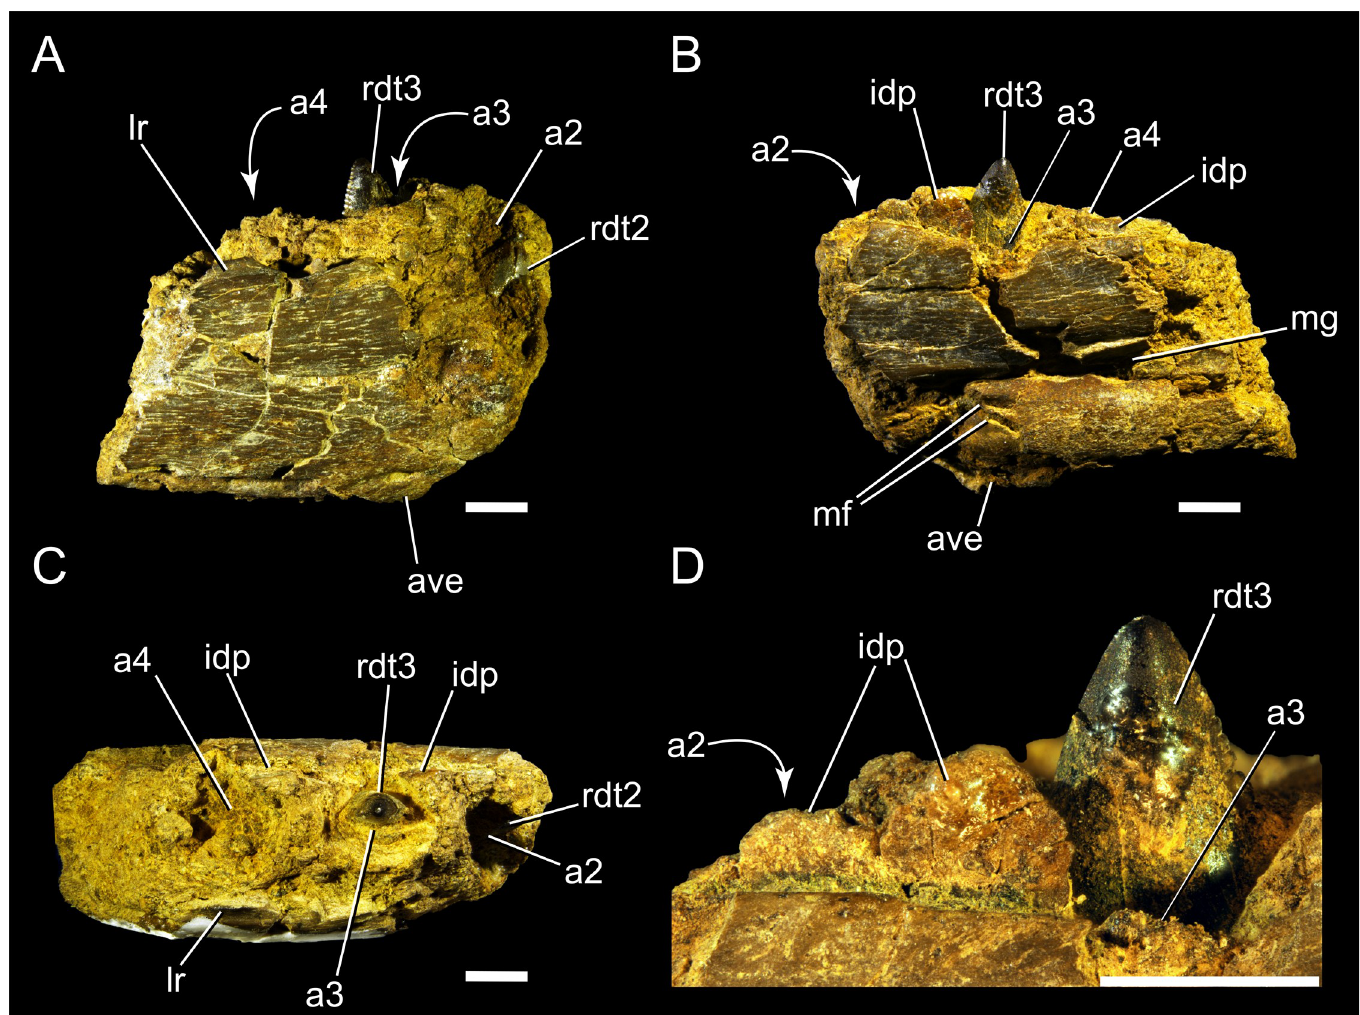
Fig 3. DMNH 21183. Anterior portion of a dromaeosaurid dentary in lateral (A), medial (B), dorsal view (C) views and close up of the interdental plates and 3 rd tooth in medial view (D). Curved arrows represent features hidden on that view. Abbreviations: a2, 2 nd alveolus; a3, 3 rd alveolus; rdt2, 2 nd dentary tooth; rdt3, 3 rd dentary tooth; rdt4, 4 th dentary tooth; ave, antero-ventral process; idp, interdental plate; lr, lateral ridge; mg, Meckelian groove; mf, Meckelian foramina. Scale bar: 2